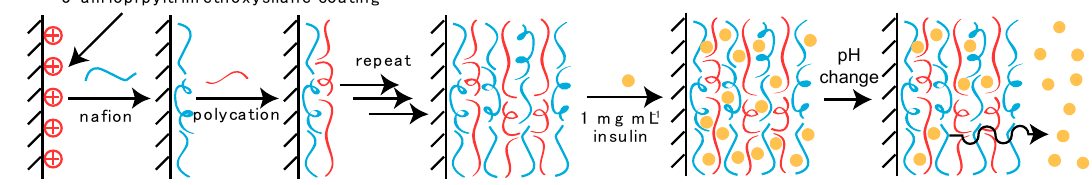
Figure 1. Schematic illustration for the preparation of a Nafion (NAF)-based layer-by-layer (LbL) film and insulin release from the LbL film in media of differing pH.